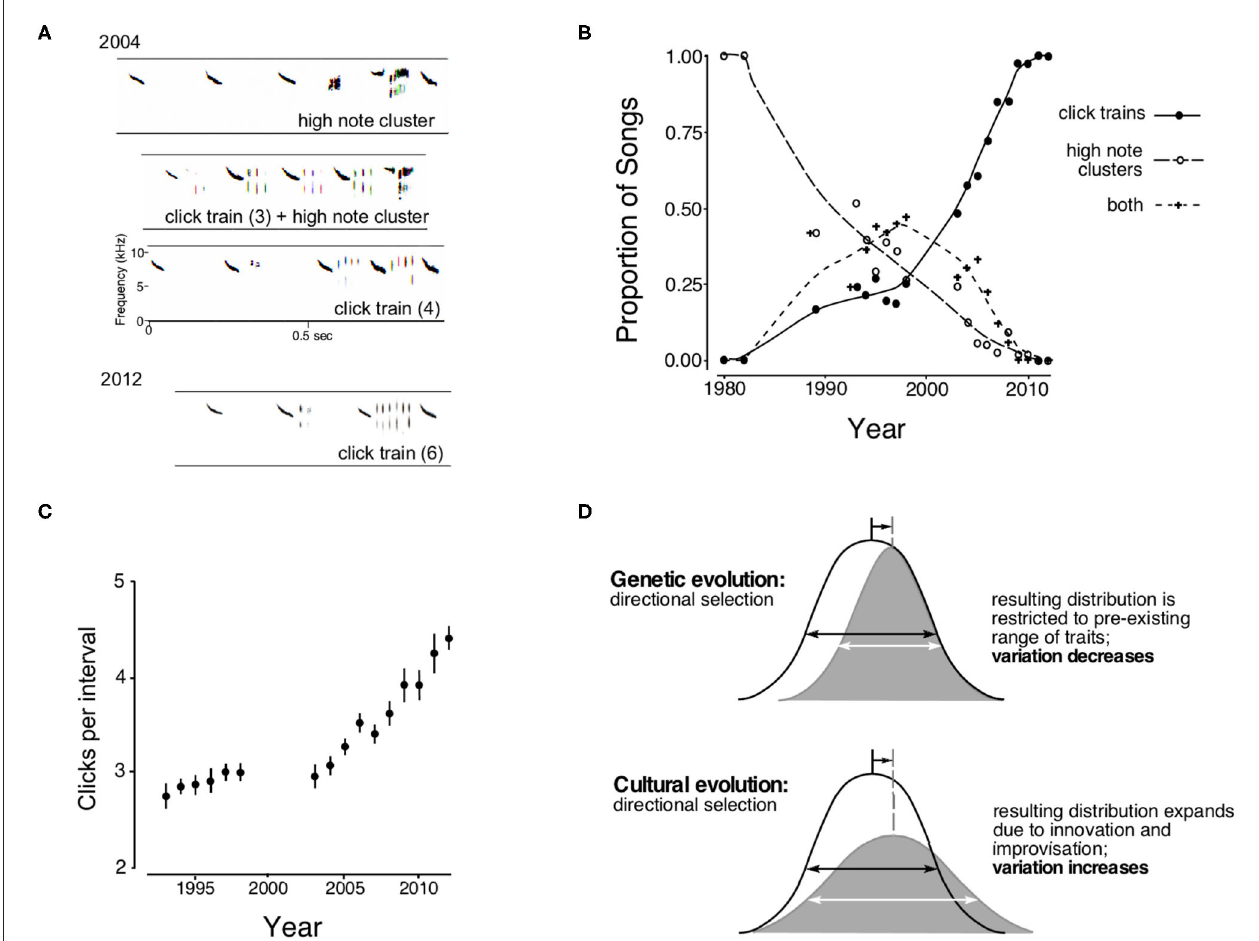
FIGURE 4 | Cultural selection: the interstitial notes of Savannah sparrow song. (A) Examples of introductory segments. In 2004, birds sang interstitial note sequences consisting of either high note clusters (top), click trains (bottom), or both types in succession (middle). In 2012 high note clusters were no longer present, and the number of clicks within an interval between introductory notes had increased. (B) The trajectory of high note cluster replacement by click trains, first sung in tandem and then as click trains alone. The curves are fitted splines. (C) Average number of clicks per interval between introductory notes for songs that included click trains (error bars represent the SEM). (D) Schematic representation of the effect of directional selection in genetic and cultural transmission. The population mean increases by the same amount for each type of selection. Horizontal double-headed arrows represent the corresponding original (black) and new (white) standard deviations (After Williams et al.,